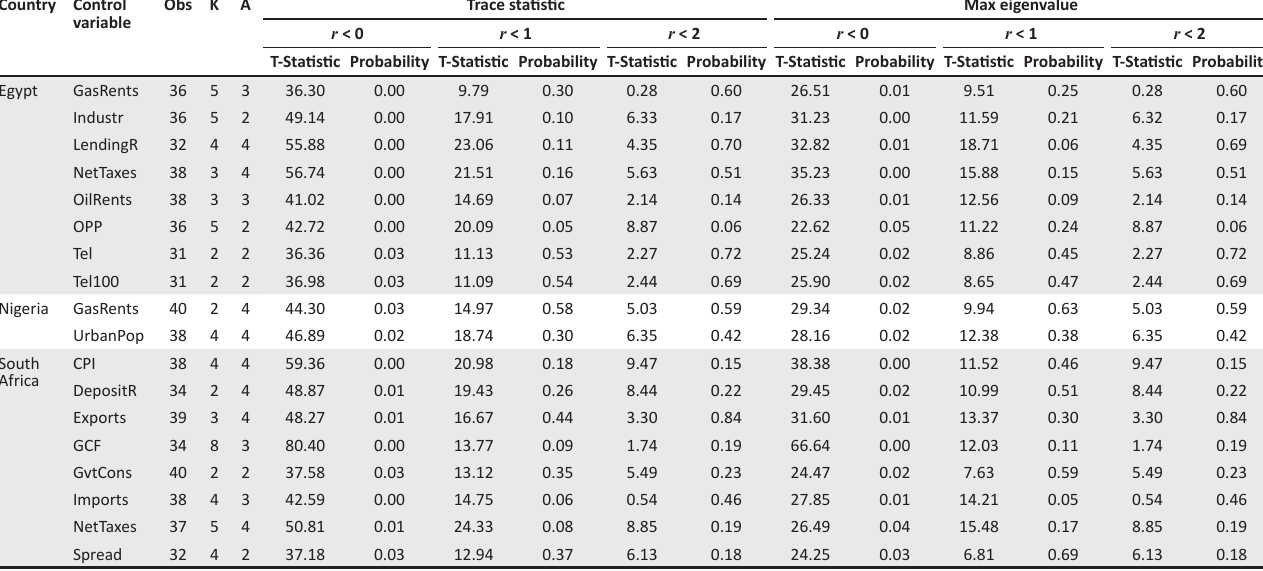
TABLE 2: Cointegration results: Egypt, Nigeria and South Africa. Country Control Obs K A Trace statistic variable